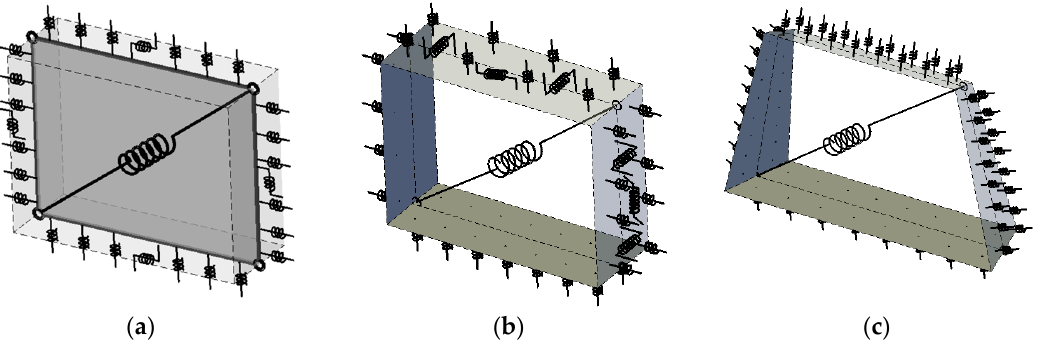
Figure 10. Layout of the macro-element at its three stages: ( a ) plane element; ( b ) spatial regular element; and ( c ) three-dimensional element for curved structures.